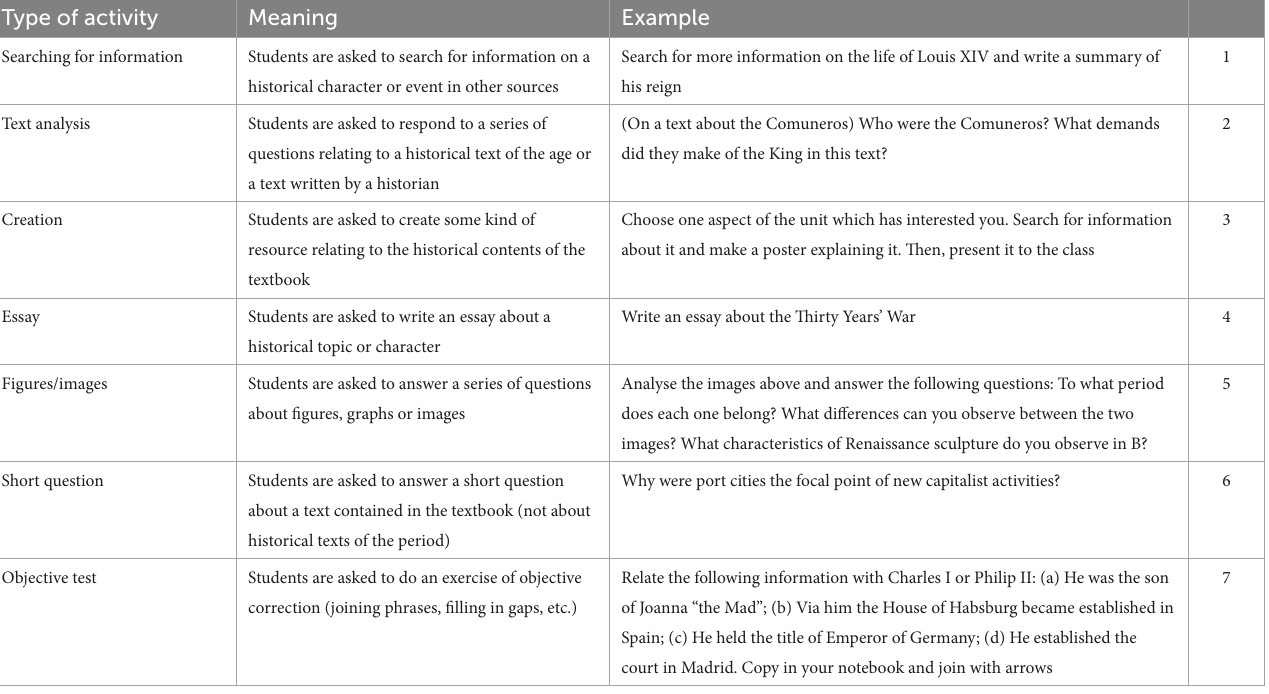
TABLE 3 Categorisation of the type of